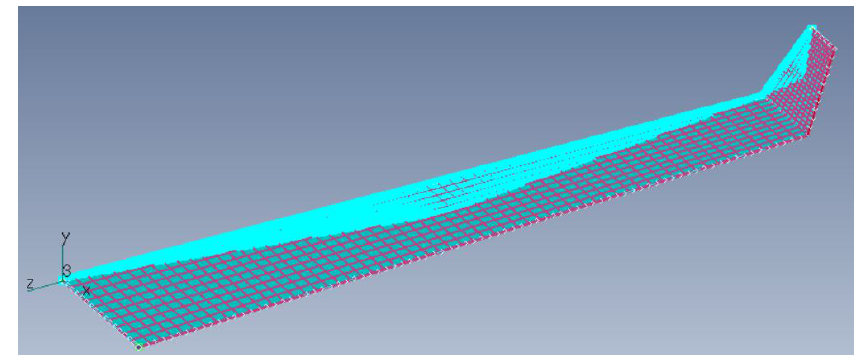
Figure 10. Wing with winglet splines connecting the Aerodynamic and Structural